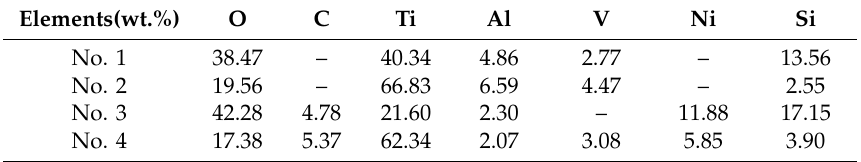
Table 3. Elemental concentrations (wt.%) of the selected areas of the worn surface using EDS.